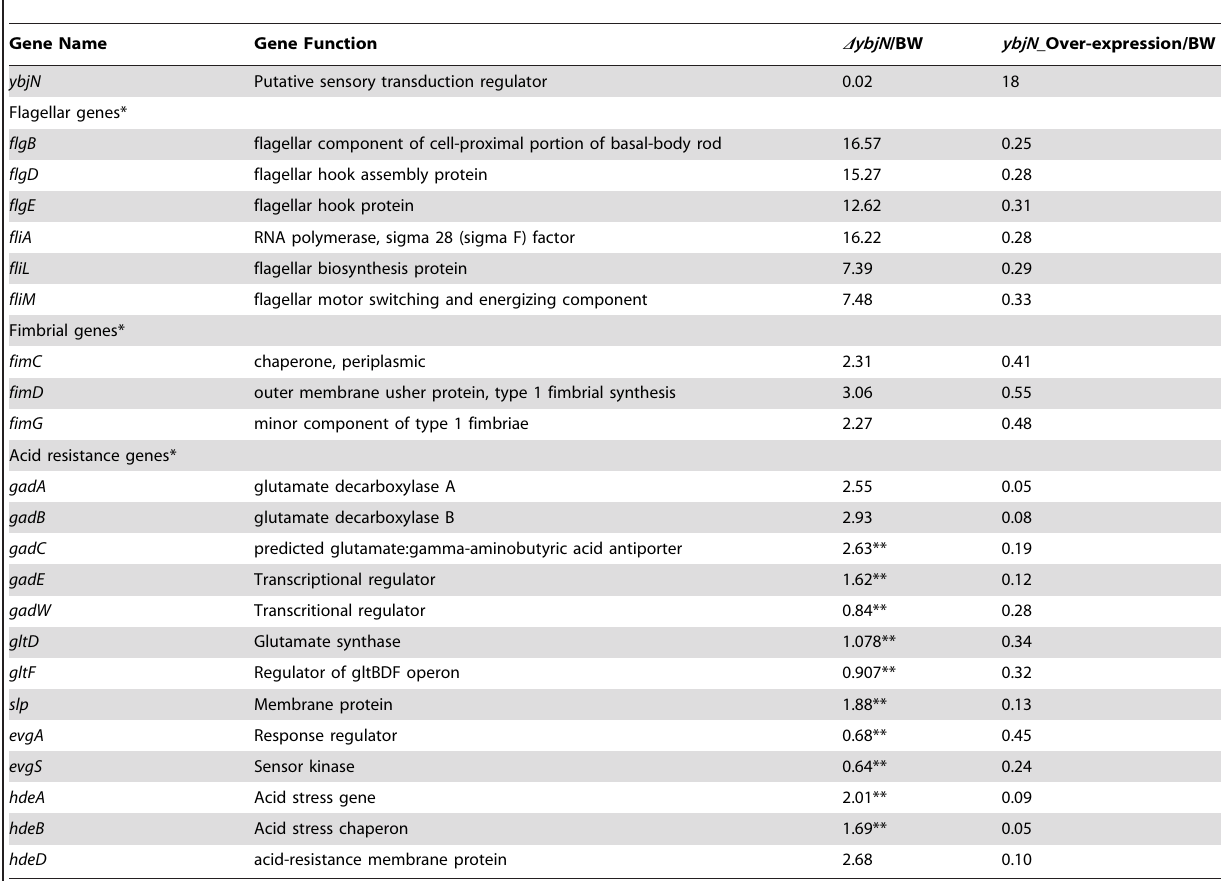
Table 1. Flagellar, fimbrial, and acid resistance genes that are inversely regulated by ybjN (p-value , 0.05).